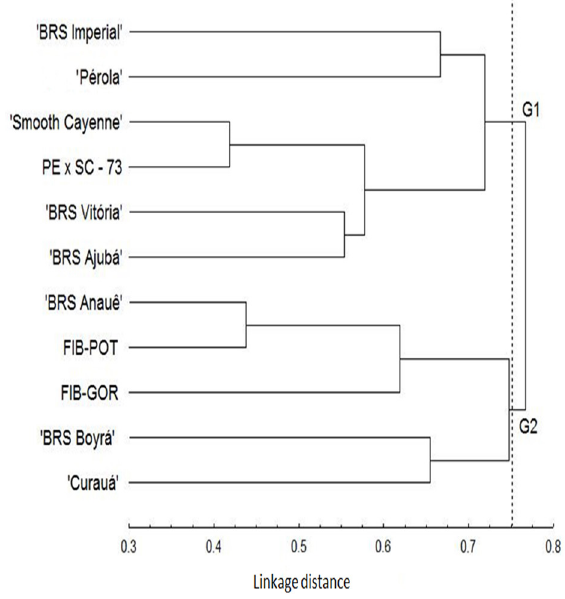
Figure 2 - Dendrogram of the 11 pineapple genotypes based on the Jaccard index and the 131 bands from 16 ISSr markers. The UPGMA method was used to define the groups and cutoff point was defined according to the parameters indicated by Mingoti